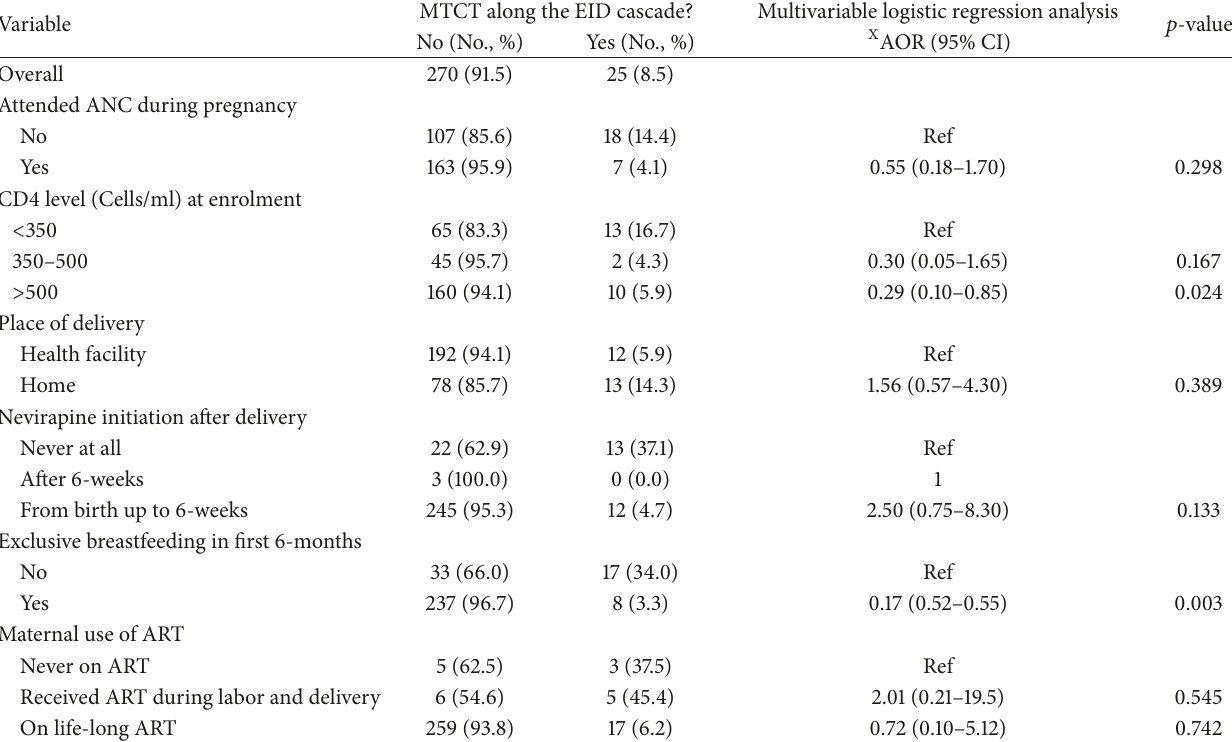
Table 3: Multivariate logistic regression analysis of factors associated with MTCT at ARRH, Northwestern